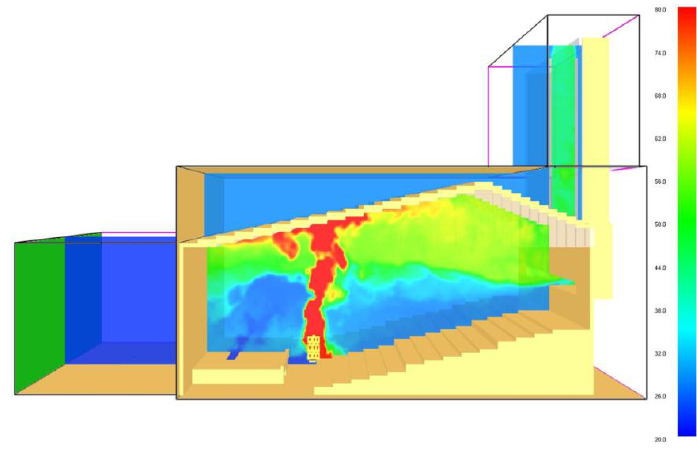
Figure 20. Temperature profile in Case F_ORG (at 120 s).